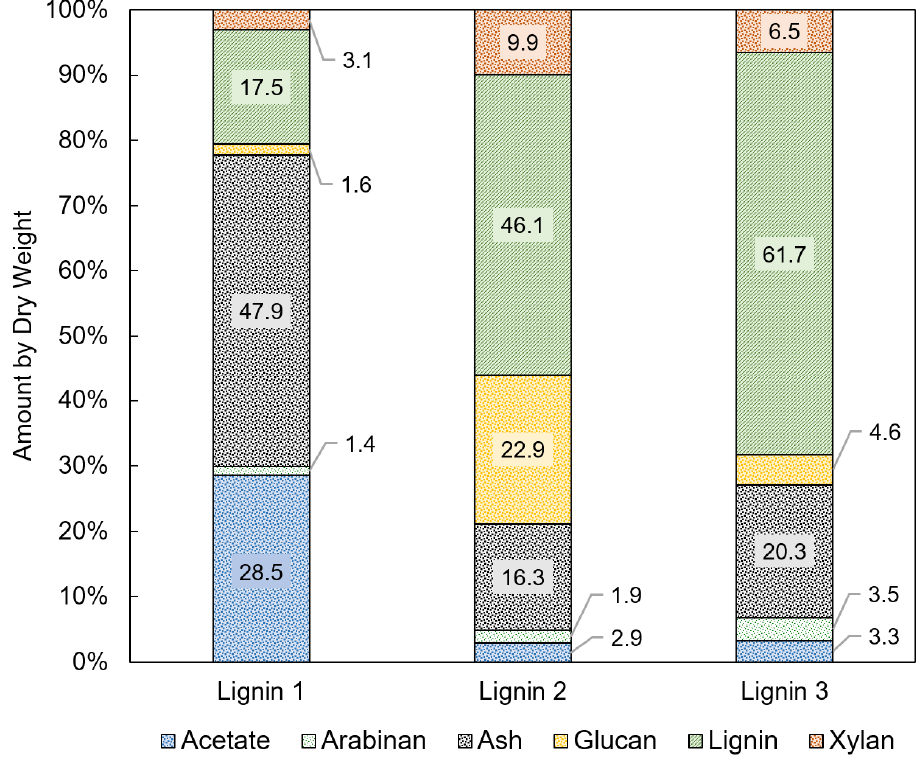
Figure 3. Compositions of Lignin 1, Lignin 2, and Lignin 3.